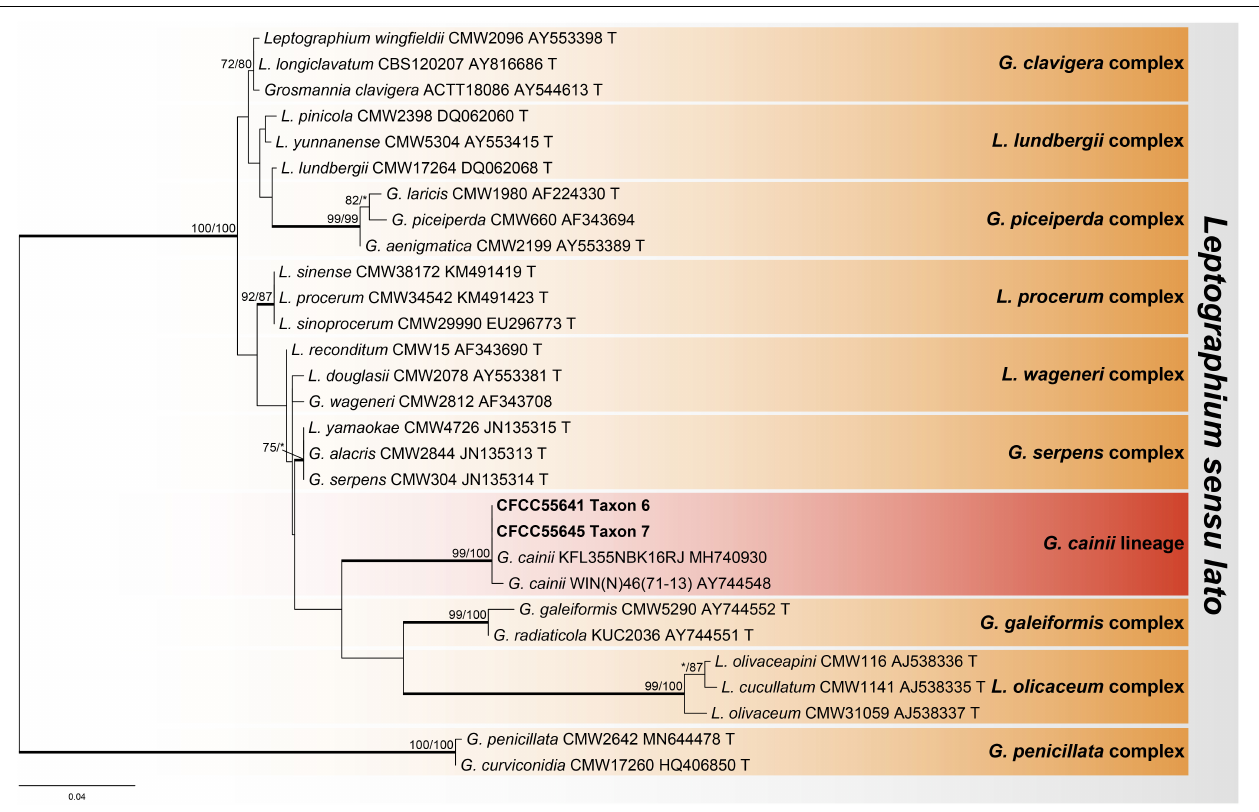
FIGURE 5 | Phylogram of Leptographium sensu lato based on ITS2-LSU sequence data. Bold branches indicate posterior probability values ≥ 0.9. The MP/ML bootstrap support values ≥ 70% are recorded at the nodes. T, ex-type isolates.